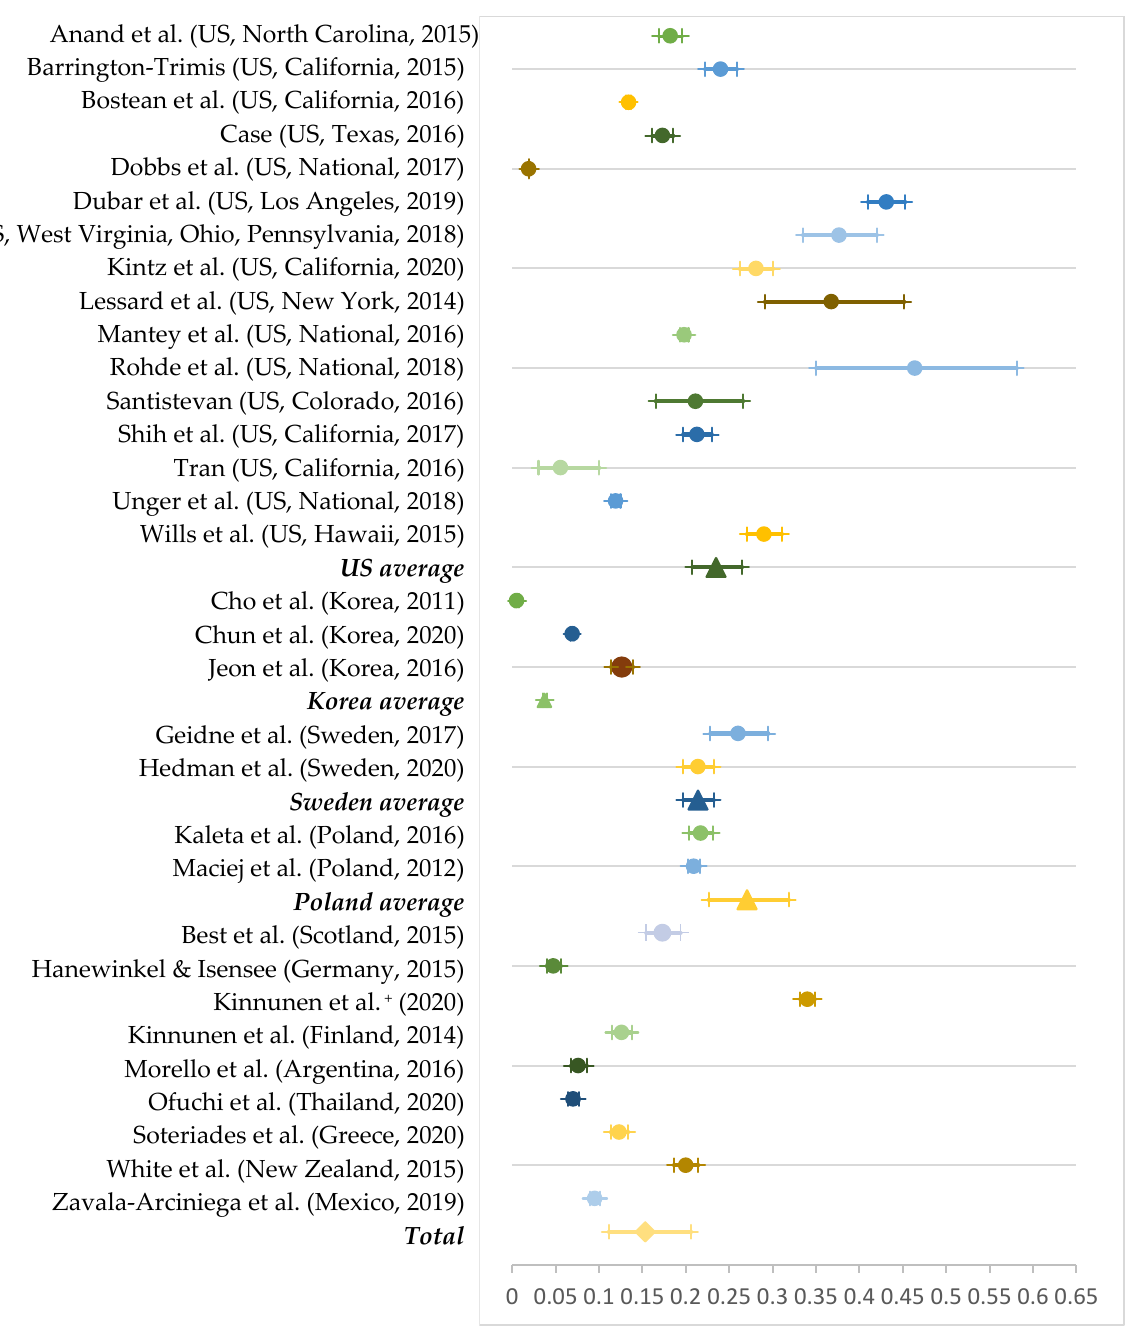
Figure 2. Prevalence of lifetime e-cigarette use by country [4,5,11,19,40–43,46–48,50–52,54,56–62,64,65,67,69–71,73,76,79,80]. Note 1. + Includes six European countries (Belgium, Finland, Germany, Ireland, Italy, Netherlands, Portugal). Note 2. National average is presented with the shape of a triangle and the total pooled prevalence as rhombus.